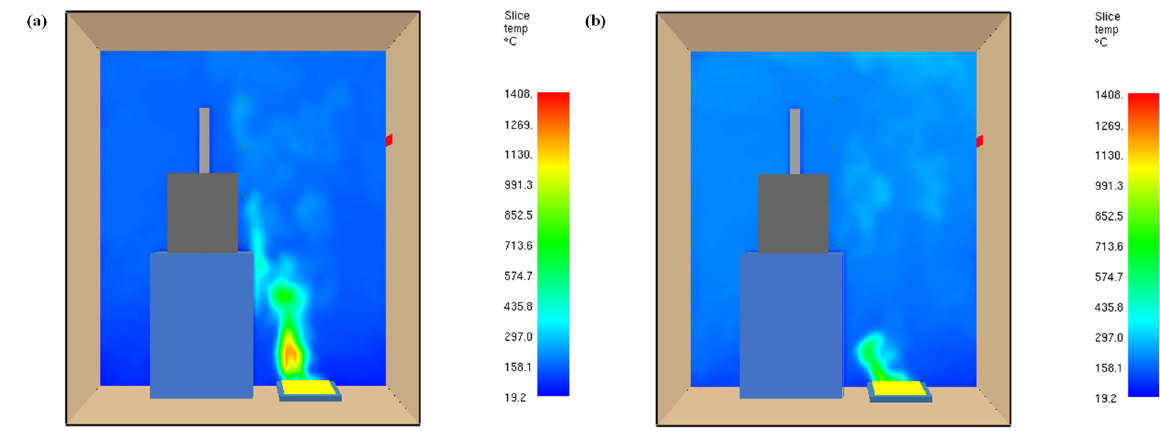
Figure 14. Vertical temperature profile on the XZ center plane ( a ) after 80 s ( b ) after 500 s.